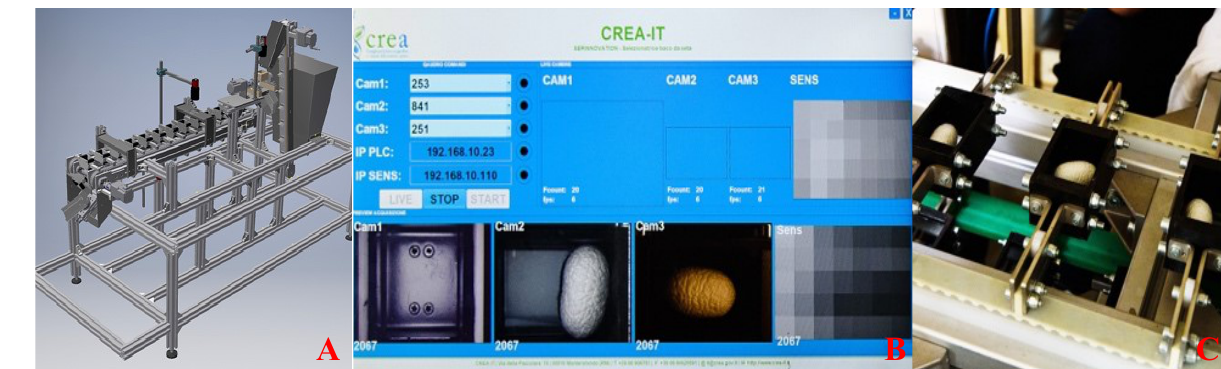
Figure 1. ( A ) 3D CAD render of the prototype, ( B ) screenshot of GUI written in Java, ( C ) custom-made conveyor belt.